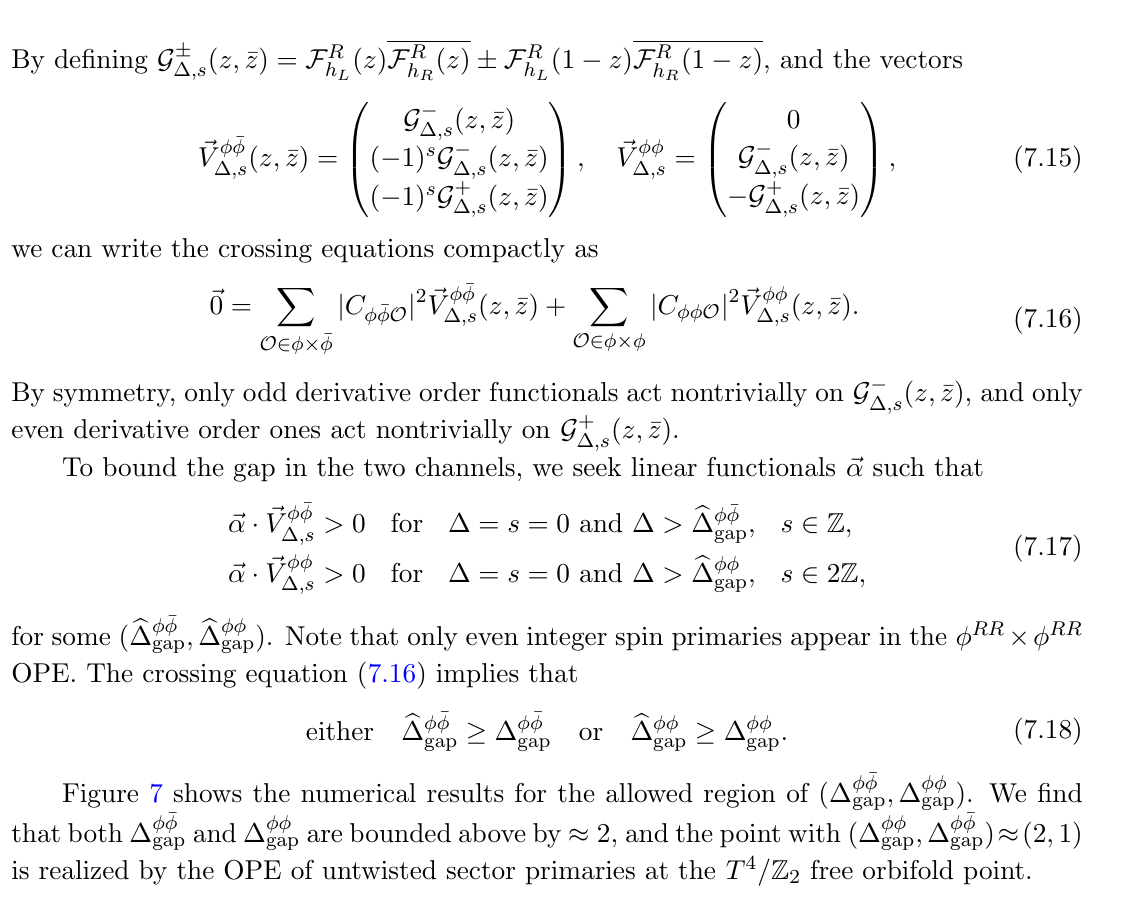
Figure 7 . The dots indicate upper bounds ( b (cid:1) (cid:30)(cid:30) at derivative orders ranging from 8 to 20. We (cid:12)nd that (cid:1) (cid:30)(cid:30) which (cid:1) (cid:30) (cid:22) (cid:30) = 0. The point (2 ; 1) is realized by an untwisted sector correlator at the T 4 = Z 2 free gap orbifold